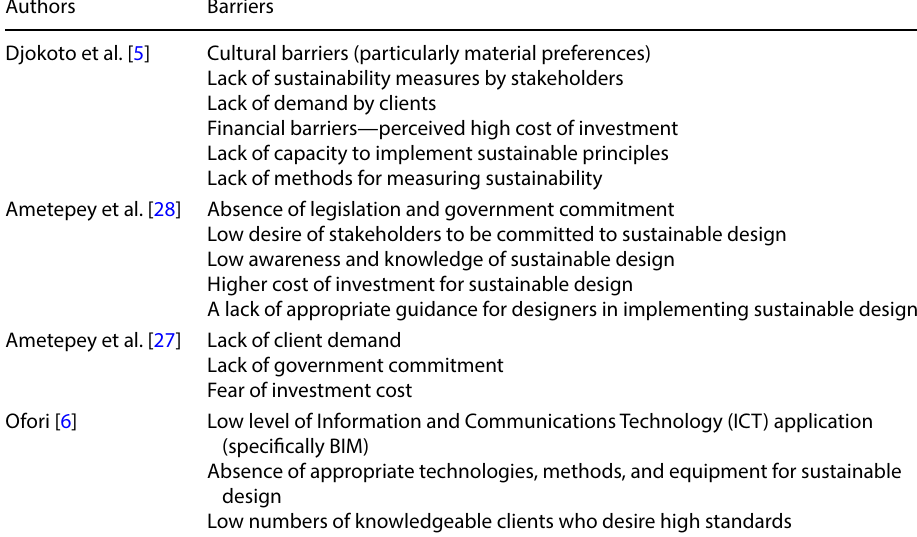
Table 1 Summary of barriers to sustainable design and construction in